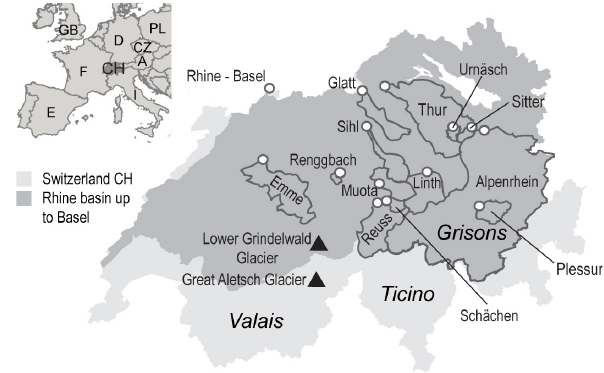
Fig. 1. Location of 14 catchments investigated and the geographical names used in this